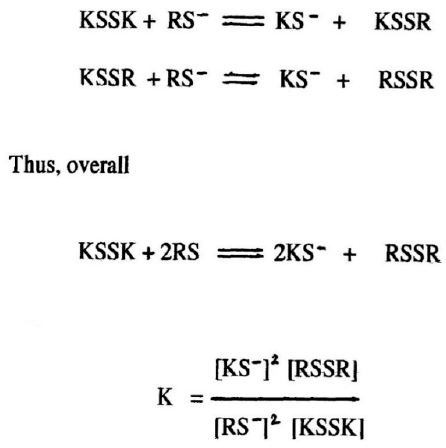
Figure 26. Scheme of the reaction between hair and mercaptans.